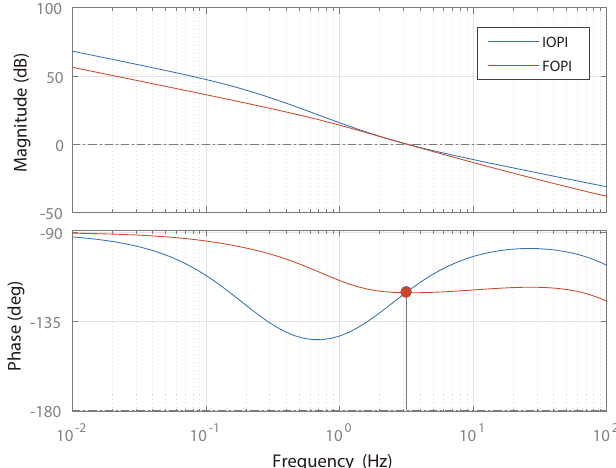
Figure 3. Open − loop Bode plot with the different